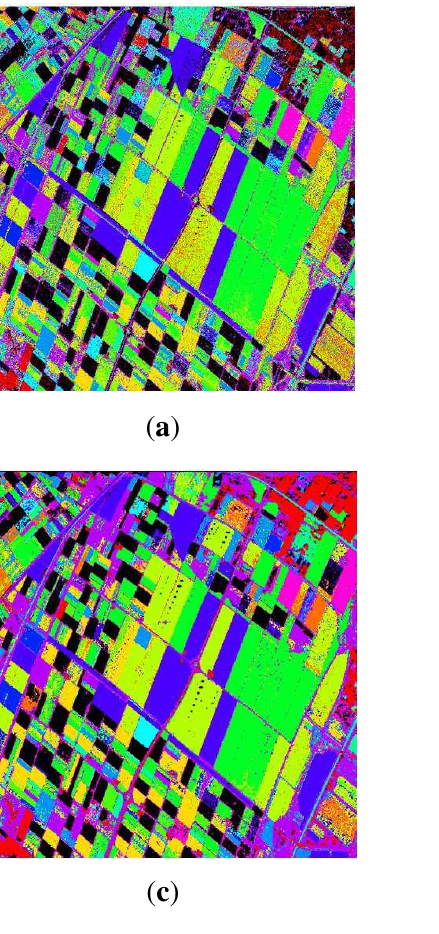
Figure 3. The classification results: ( a ) the Wishart algorithm; ( b ) the Wishart algorithm with filtered data; ( c ) the NN classifier with original data unfolded into a vector; ( d ) the proposed